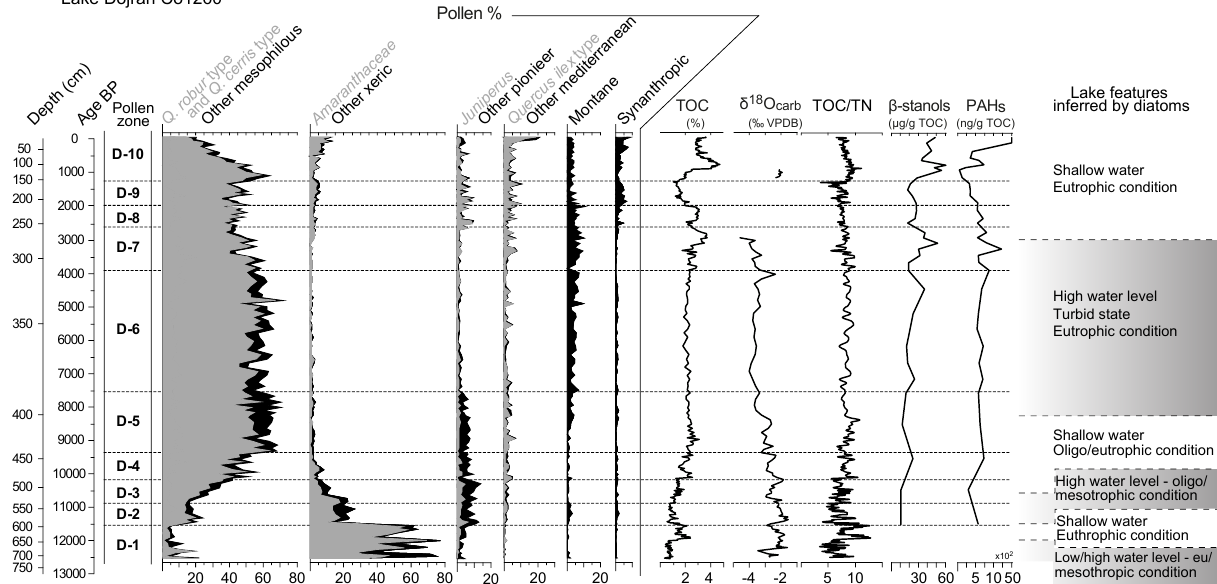
Figure 4. Pollen percentage diagrams of plant groups. Mesophilous: Acer , Buxus , Carpinus betulus , Celtis , Corylus , Fraxinus excelsior– oxycarpa , Hedera , Ostrya–Carpinus orientalis , Quercus robur type, Quercus cerris type, Tilia , Ulmus . Xeric: Amaranthaceae, Artemisia , Helianthemum . Pioneer: Betula , Corylus , Ephedra , Juniperus , Rosaceae. Mediterranean: Arbutus , Fraxinus ornus , Cistus , Pistacia , Phillyrea